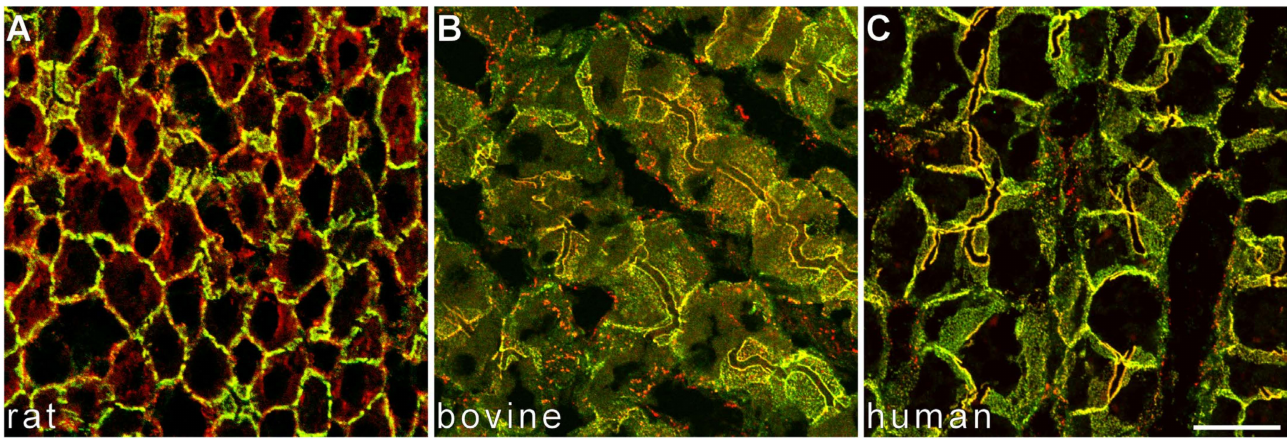
Figure 1. N-cadherin colocalizes with E-cadherin in hepatocytes of normal liver. Double label laser scanning microscopy shows near-complete colocalization of E-cadherin ( A – C , green) and N-cadherin ( A – C , red) in hepatocytes of rat ( A ), bovine ( B ), and human liver ( C ). Bar: 20 µ m. Therefore, to investigate whether E- and N-cadherin were detected in one complex in liver and HCC tissue in situ, we performed confocal laser scanning fluorescence microscopy of normal liver tissue, and both E- and N-cadherin were colocalized with the plaque proteins α - and β -catenin at the AJs at the border to the bile canaliculi and at the basolateral cell membrane (Figure 3). In contrast to E-cadherin, N-cadherin was localized together with α - and β -catenin in dot-like AJ, mutually corresponding to AJs of hepatic stellate cells (HSCs), whereas only catenins together with VE-cadherin lined the delicate AJs of liver sinusoidal endothelial cells (LSEC, see G é raud et al. [45]). In HCA and HCC in situ, colocalization of E- and N-cadherin with the respective catenins were retained (Figure 3), pointing to robust and stable complexes during hepatocarcinogenesis. In examples of well, moderately, and poorly differentiated human HCCs, E- and N-cadherin were colocalized together with the plaque proteins α and β -catenin (Figure 3), plakoglobin, and protein p120-ctn, but as expected not with the tight junction protein ZO-1; however, our analyses also visualized the distorted architecture of HCC with respect to apico-basolateral polarity as demonstrated by the tight junction protein ZO-1 in HCC cells, the increase in atypical vessels positive for protein ZO1 and p120 ctn, and the previously shown loss of N-cadherin- positive HSCs in HCC (Figures 3 and